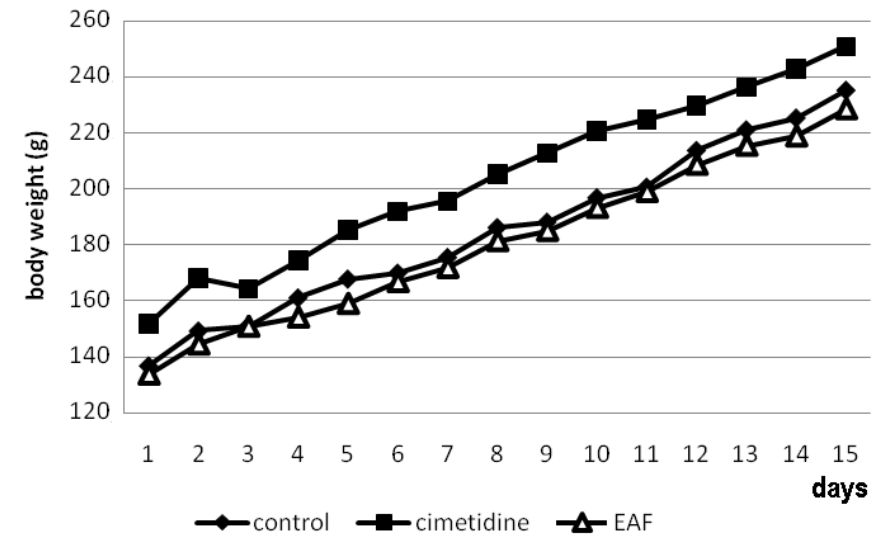
Figure 1. Effects on body weight of a single dose (100 mg/kg, p.o.)/day of ethyl acetate fraction of Alchornea triplinervia leaves (EAF) administered during 14 consecutive days after ulcer formation (n = 6). Results are expressed as mean of body weight